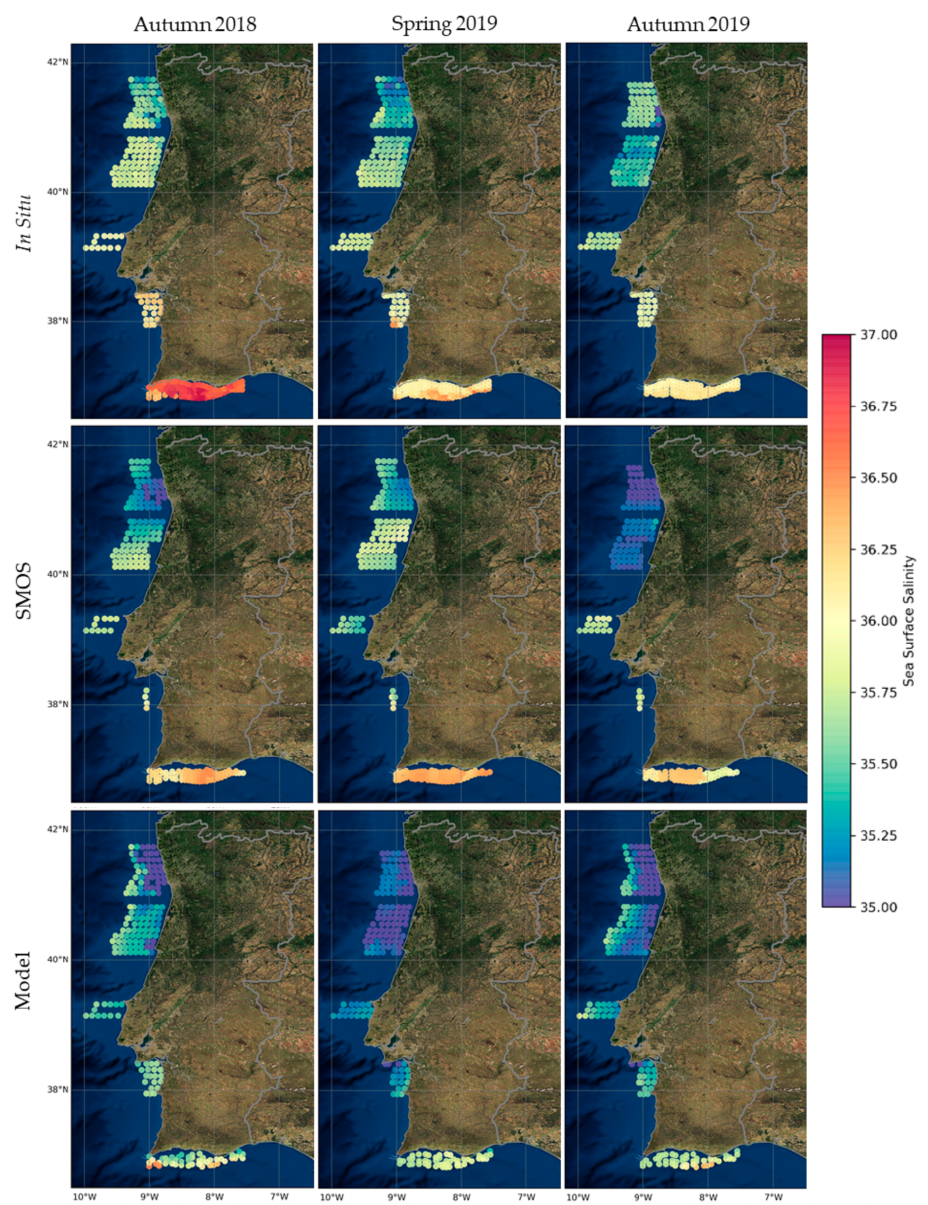
Figure 2. Surface salinity spatial distribution observed in Autumn 2018, Spring 2019, and Autumn 2019 considering all the available in situ observations and the satellite and modelled data used in the matchup